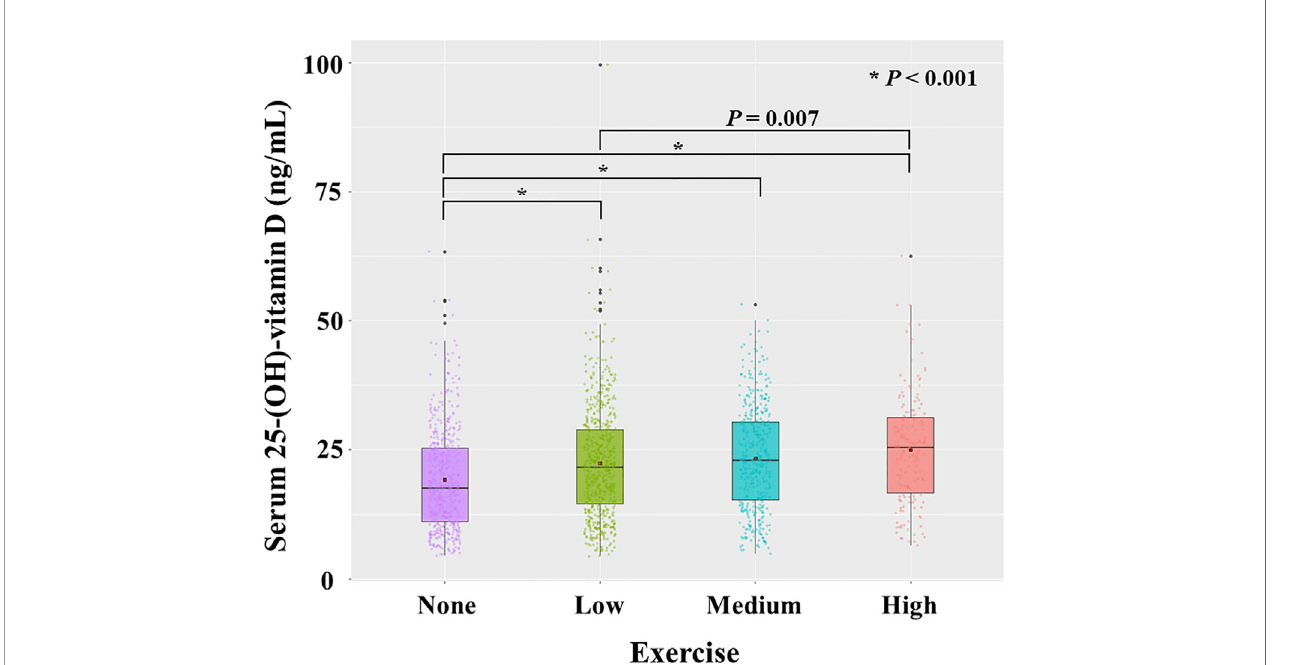
FIGURE 5 | Distribution of serum level of 25-(OH)-vitamin D according to exercise. Each dot represents the individual value of 25-(OH)-vitamin D. Box plots show group medians, interquartile range (IQR), and spread of data with outliers for each group. A dot in each box plot shows the mean value. P values were calculated with student t test.